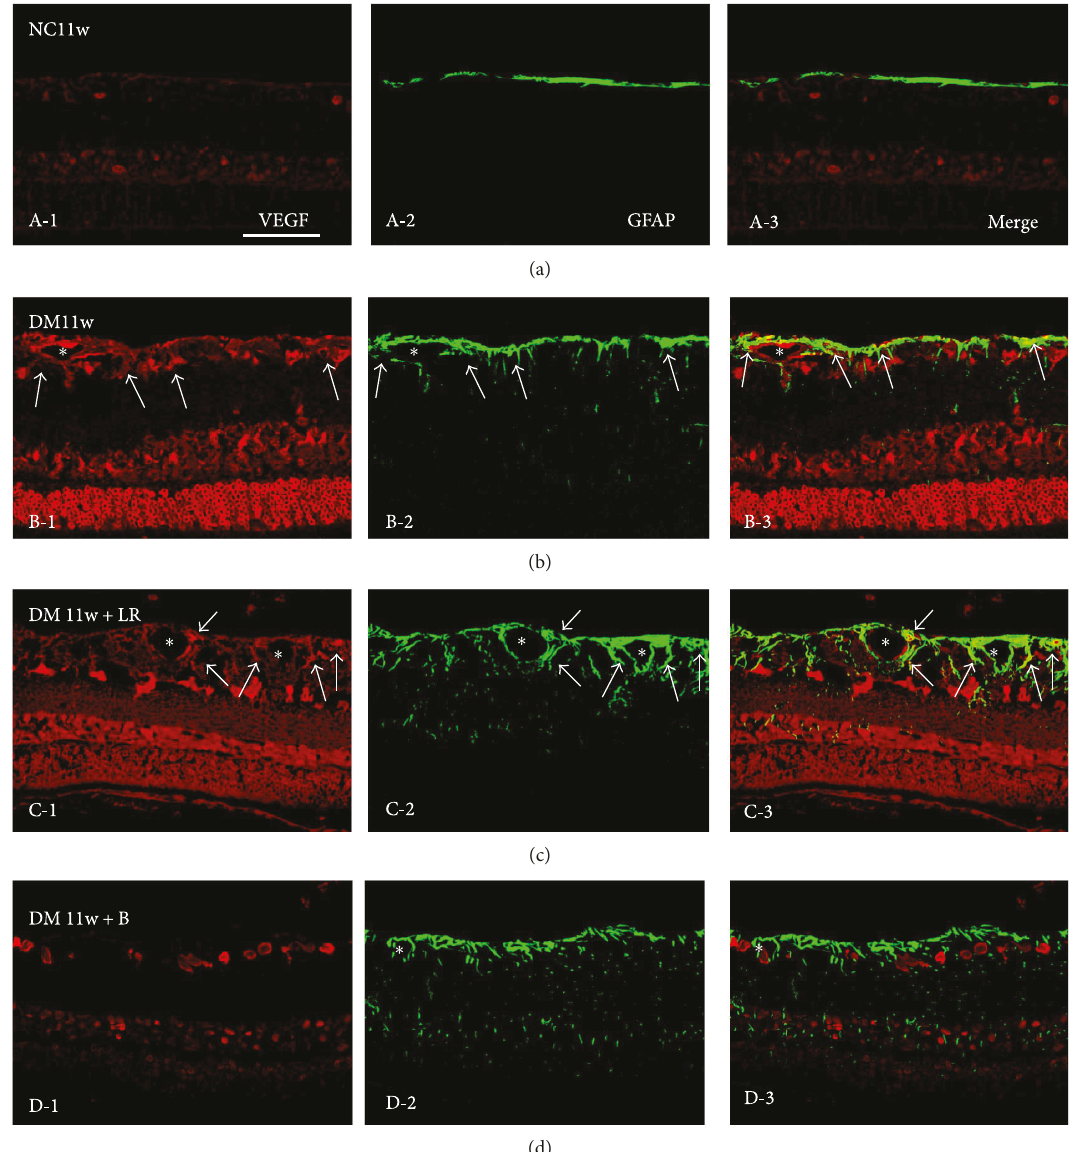
Figure 11: Representative photomicrographs of VEGF (red) and GFAP (green) double staining of the retina in the NC11w, DM11w, DM11w +LR, and DM11w+B groups. VEGF immunoreactivity was localized in GFAP-labeled astrocytes (single arrow) and blood vessels (asterisk). (b, C-2) GFAP expression appeared to be enhanced in the DM11w and DM11w+LR, consistent with the expression of VEGF in these two groups. (A-1, 2, D-1, 2) By contrast, both VEGF and GFAP expressions were relatively lower in the NC11w and DM11w+B groups. Note the dilated blood vessels in diabetic retina at the DM11w+LR group (asterisk). Bar=50 μ